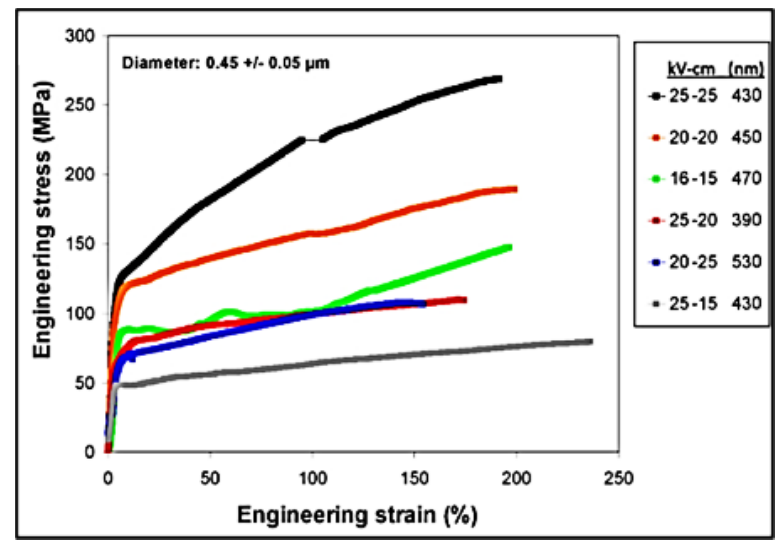
Figure 10. Stress–strain relationship of individual PAN nanofibers [105].